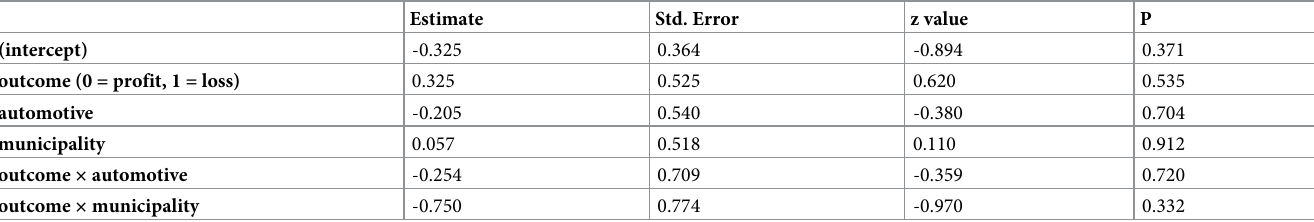
Table 6. Logistic regression with a dummy for label as the dependent variable for label first.